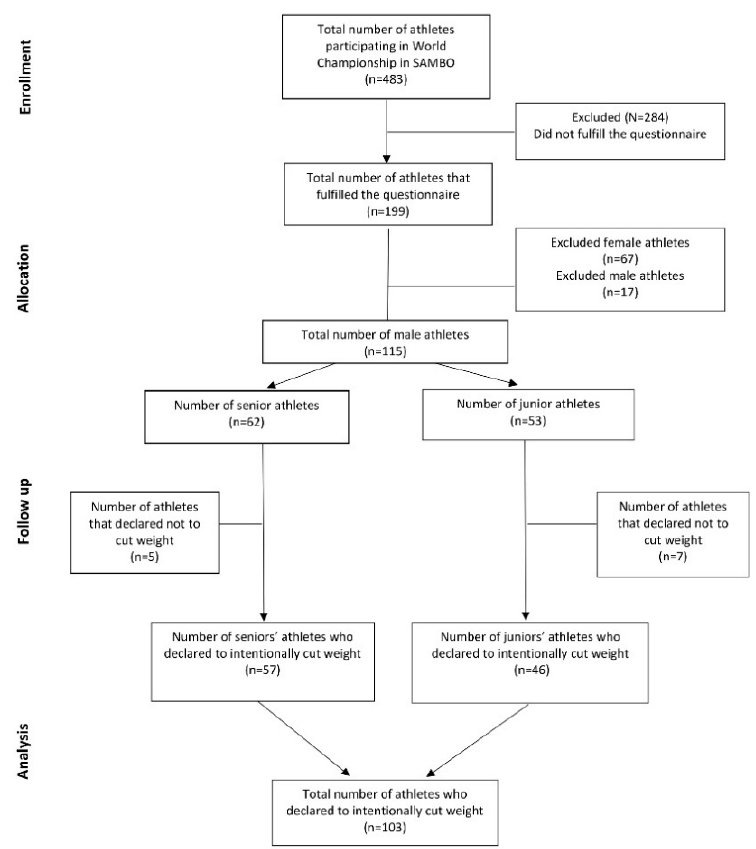
Figure 1. Flow of participants.